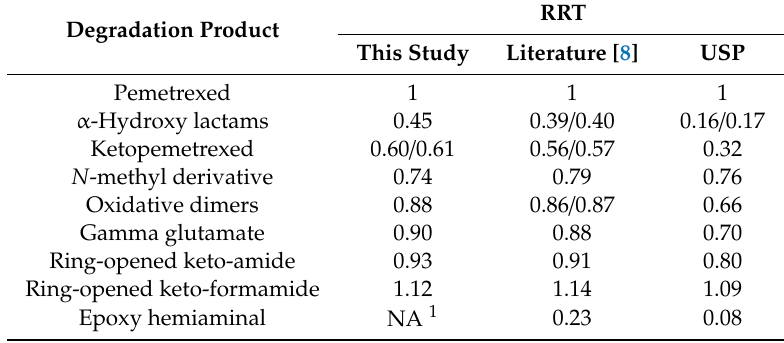
Table 4. Relative retention time (RRT) of pemetrexed’s degradation products.